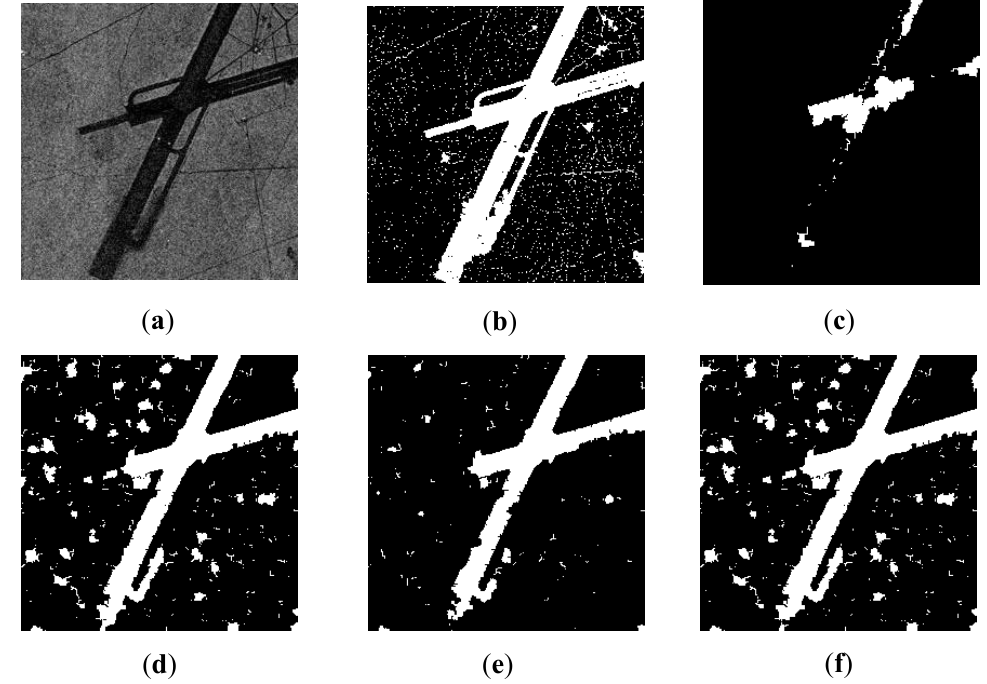
Figure 13. Segmentation results on SAR4. ( a ) original image; ( b ) AFWDLMO; ( c )